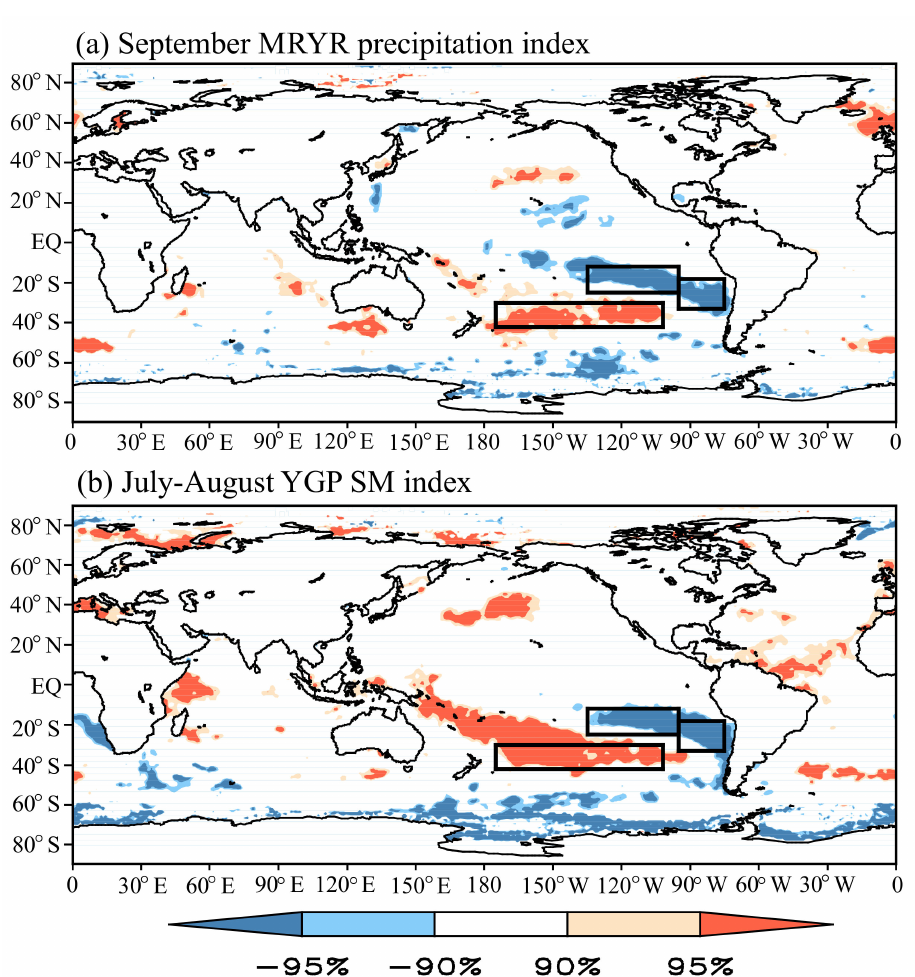
Figure 7. ( a ) Distribution of correlation coefficients between the September observational MRYR precipitation index and July–August SSTs during the period 1979–2021; ( b ) As in ( a ), but for that between the July–August YGP SM index and simultaneous SSTs. Shadings denote the correlation significance at the 90 and 95% confidence levels, as shown by the color bars. The black boxes indicate the key regions for the definition of the SPSP